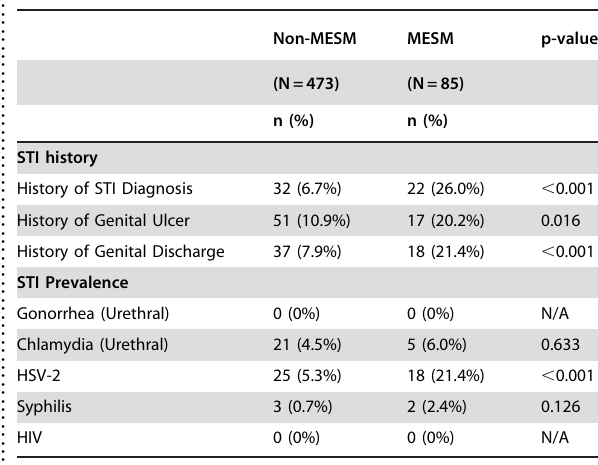
Table 2. Prevalence and history of sexually transmitted infections (STIs) among general population males: